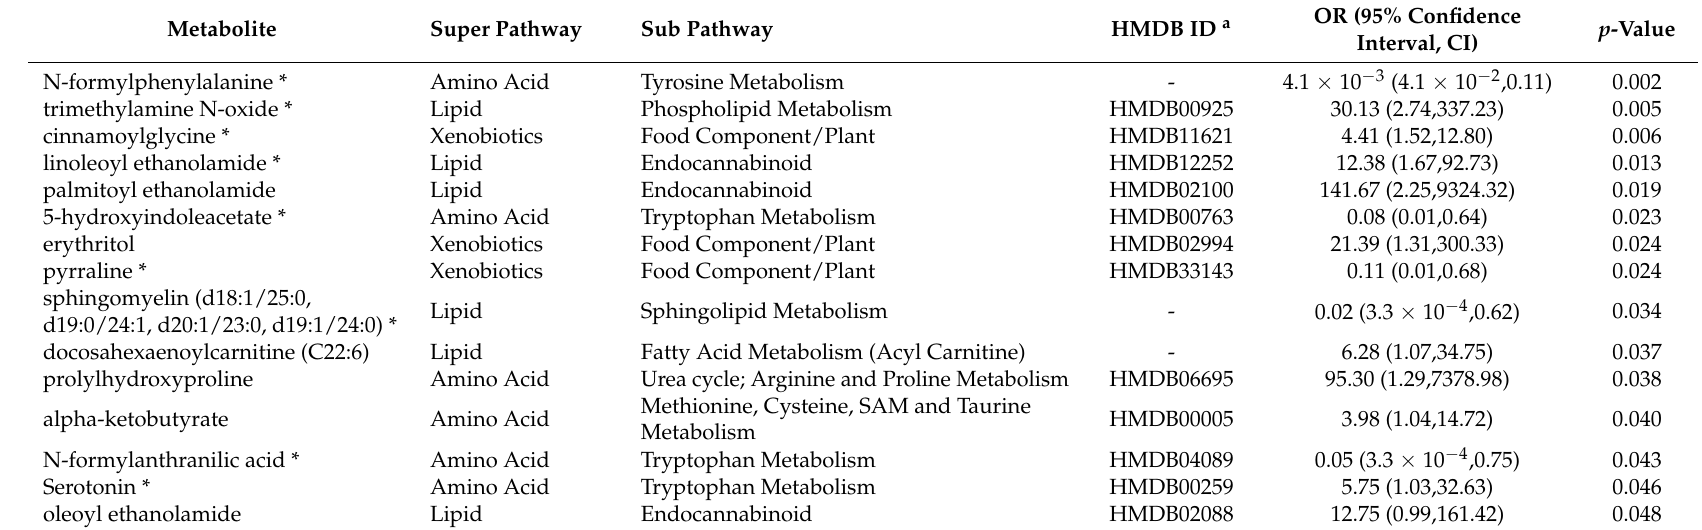
Table 2. Plasma metabolites associated ( p < 0.05) with binary ASQ communication score